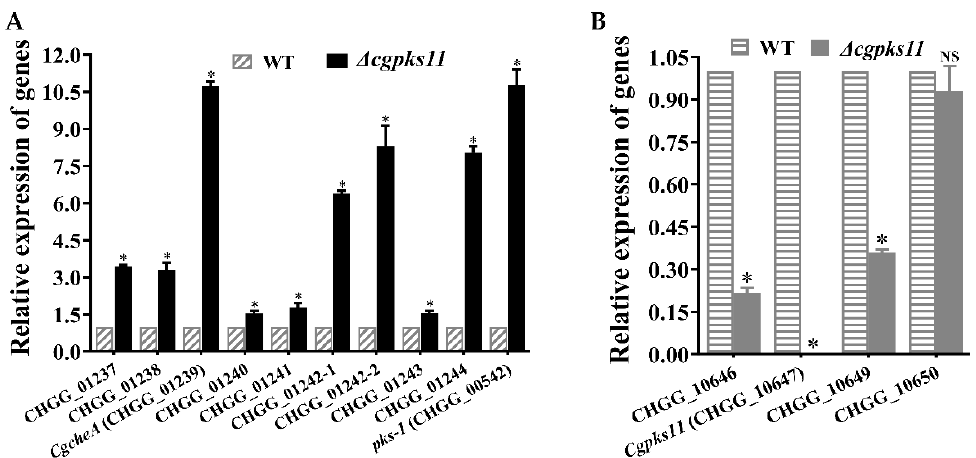
Figure 6. Expression of genes involved in ChA and chaetoglocin A biosynthesis in the wild-type strain and ∆ cgpks11 mutant. ( A ) The expression of the ChA biosynthesis gene cluster (genes from CHGG_01237 to CHGG_01244) and pks-1 that were proved to be associated with ChA biosynthesis. ( B ) Detection of transcription levels of the genes involved in chaetoglocin A biosynthesis. There is significantly difference between the mutant and wild-type strains as indicated by an asterisk ( p -value < 0.01 with t -test analysis). Experiments were performed in triplicate.